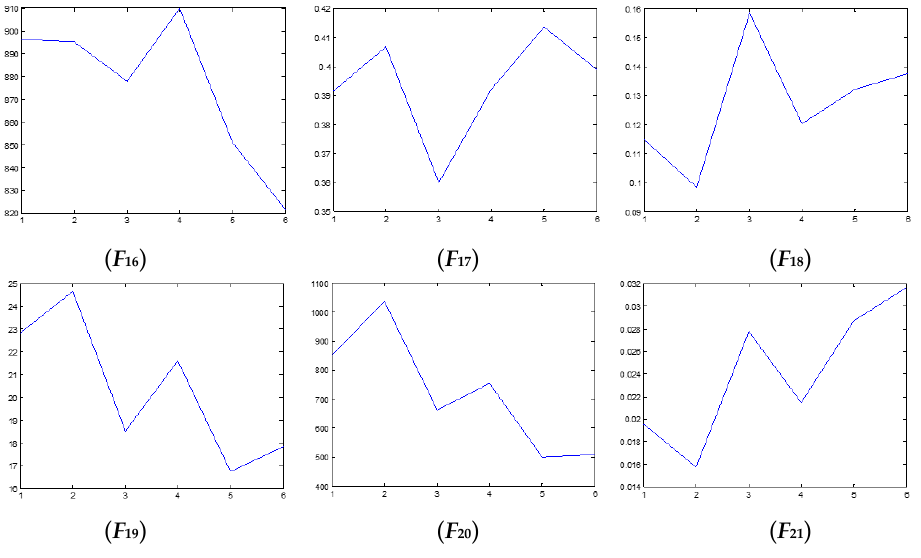
Figure 19. The analyzed results of A fan No. 2H sensor by F 16 – F 21 .